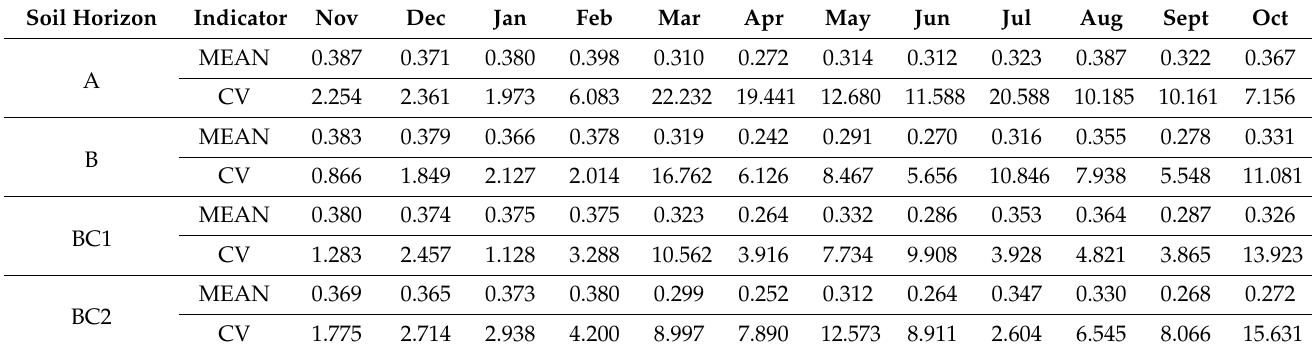
Table 8. Monthly means of the soil water content (cm 3 · cm − 3 ) and coefficients of variance (CV) in HY 2016.